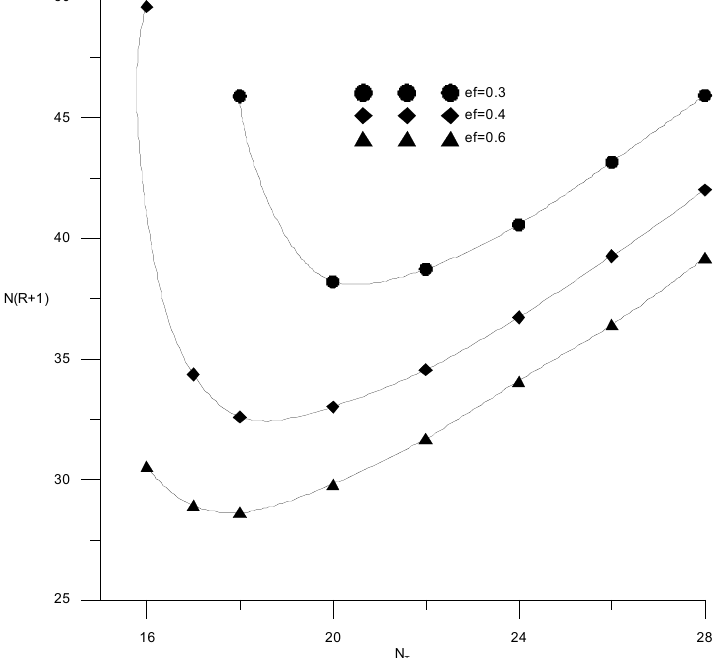
Figure 14. Capital costs for extractive rectification from the number of trays in the column at different flow rates of fresh extractant.